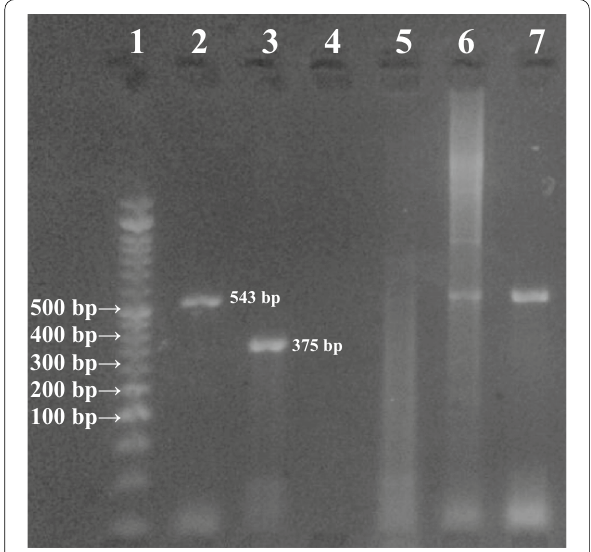
Fig. 1 Agarose gel stained with ethidium bromide for Schistosoma spp. PCR product: Lane 1; molecular weight marker (50 bp), Lane 2; positive control S. haematobium (543 bp), Lane 3; positive control S. mansoni (375 bp), Lane 4; negative control, Lane 5; negative sample, Lanes 6 and 7; positive samples (543